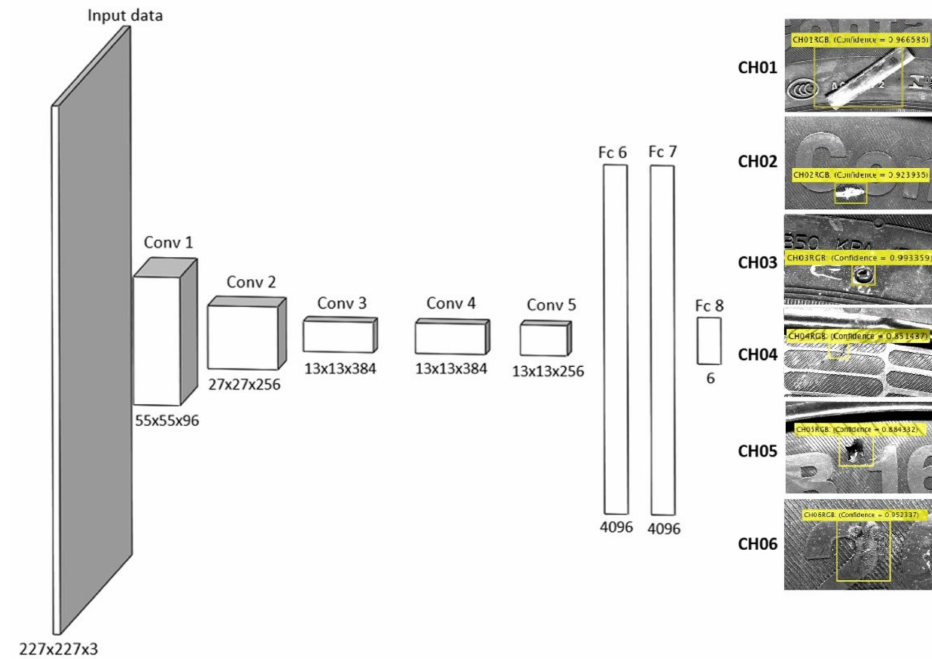
Figure 13. Architecture of used modified network AlexNet for our task.